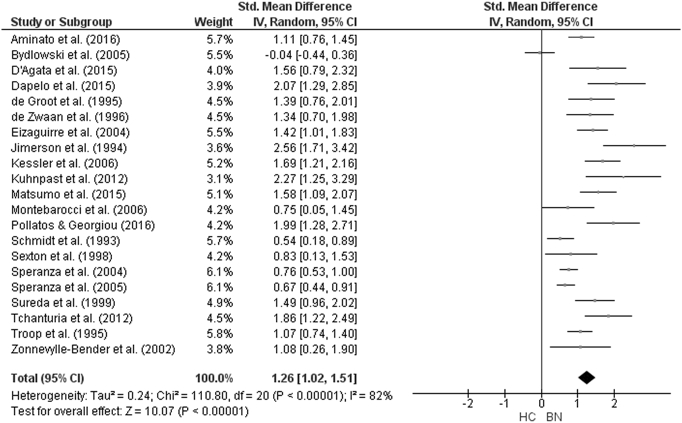
Forest plot of mean TAS score: standardized mean effect size for differences (SMD) between Bulimia Nervosa (BN) and Healthy Controls. CI, confidence interval.